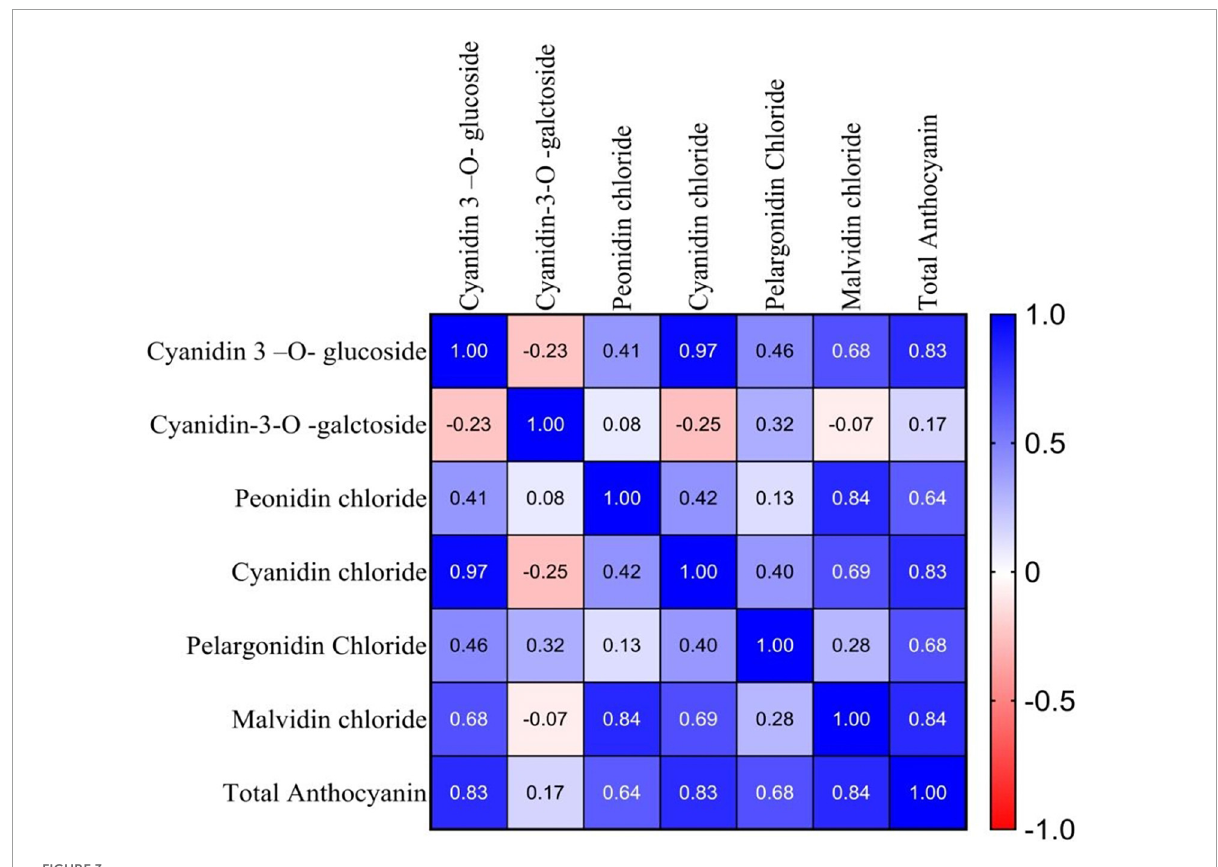
FIGURE3 Correlation coefficients (r) between major groups of anthocyanin pigments of selected germplasm.